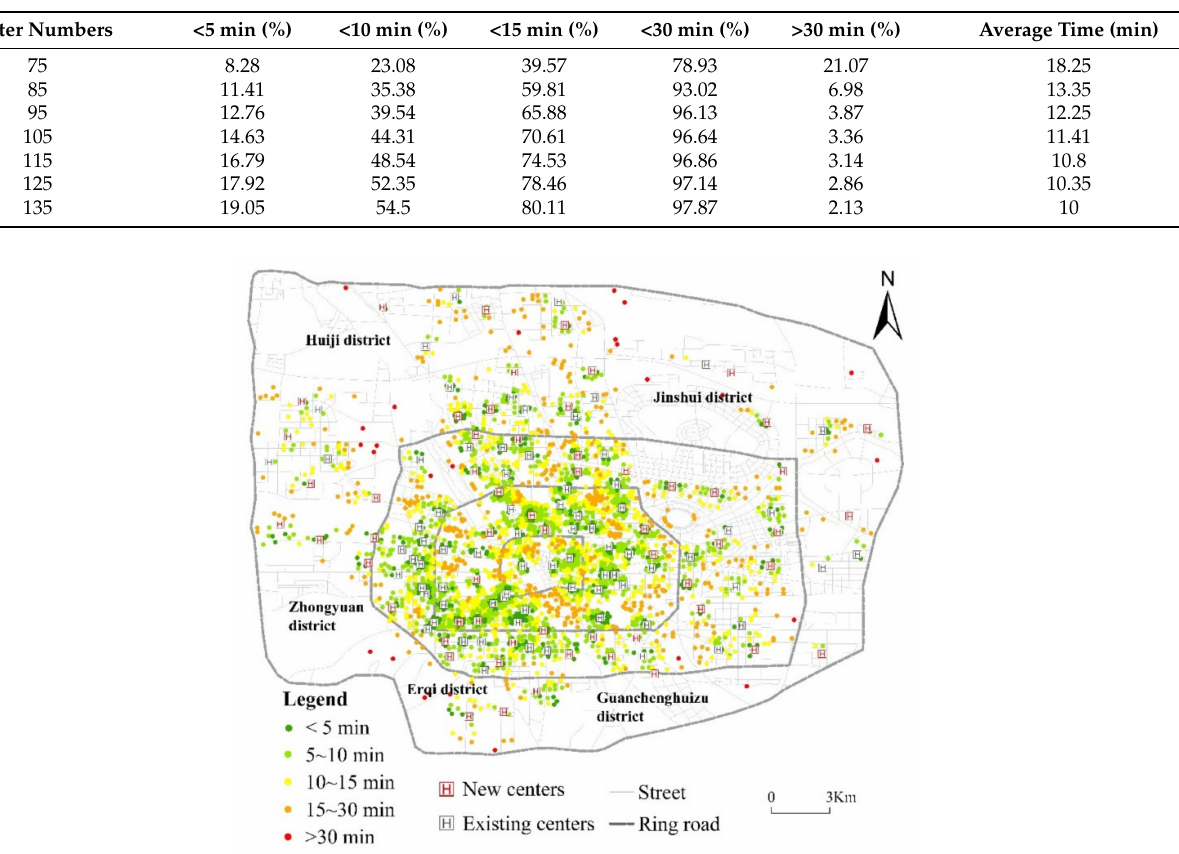
Table 4. Statistics of the population coverage of the healthcare services with different center numbers.